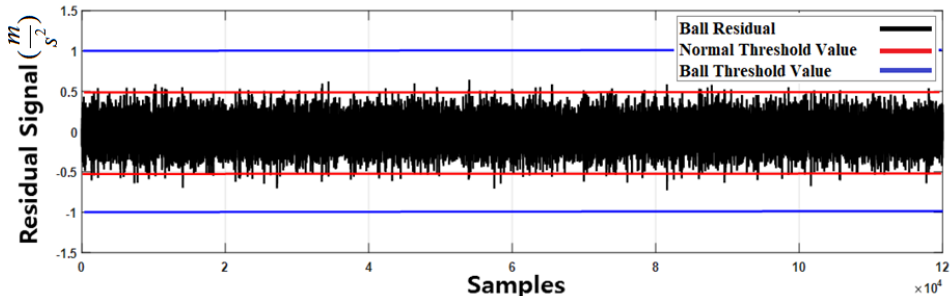
Figure 13. Ball residual signal, normal threshold signal, and ball threshold signal for the ball faulty condition with a crack width of 6 mm.